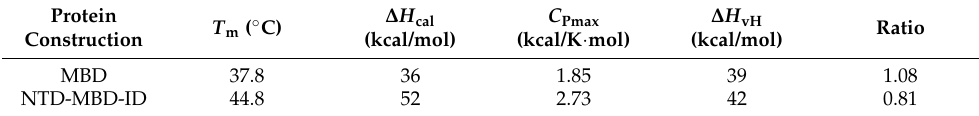
Table 1. Parameters associated with the van ‘t Hoff test (or calorimetric two-state test).